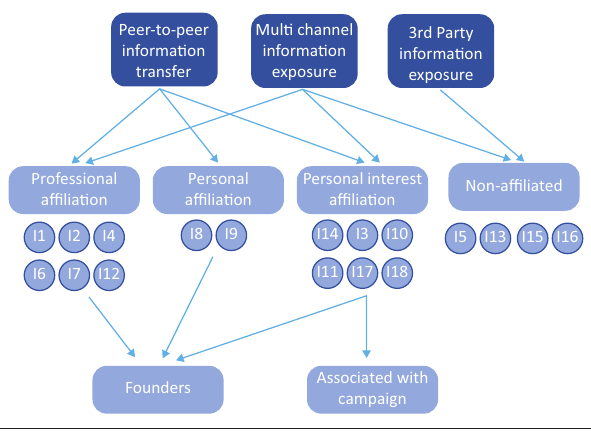
FIG URE 3: Relational map of founders and funders.